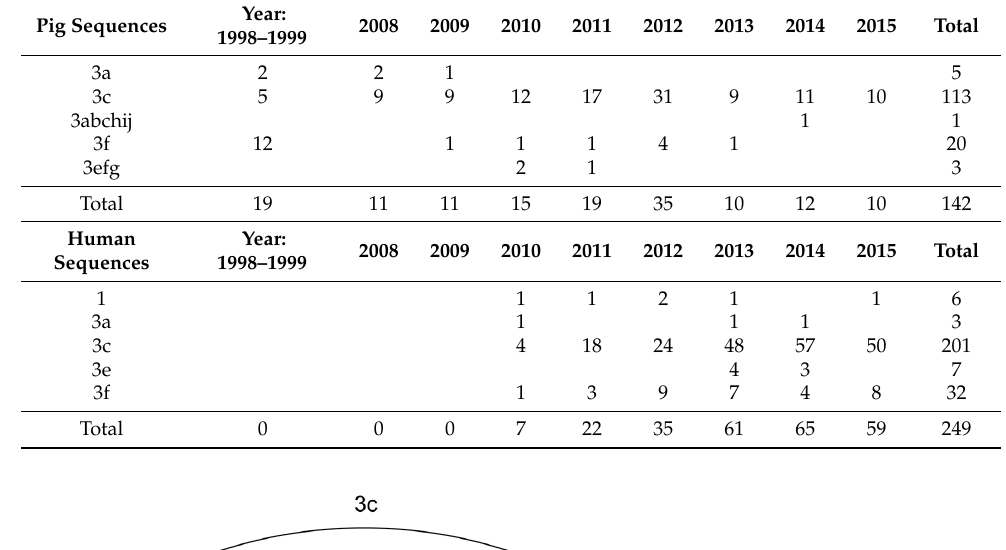
Table 1. Distribution of HEV sequences among the various HEV subtypes over the years in pigs and humans. The total number of all subtypes as depicted in Figure 1 was calculated (ORF1 and ORF2 combined). If no subtype could be assigned the sequence were classified as clade 3efg or 3abchij. For genotype 1 no subtypes were assigned because of the low number of gt1 infections.